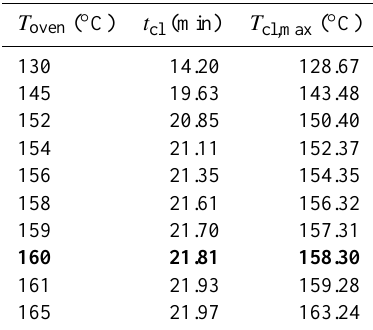
Table A4. Pre-calculated cross-linking parameters (for T cl , 0 = 22 ◦ C and t oven = 25min). The bold font indicates the optimal pa- rameter